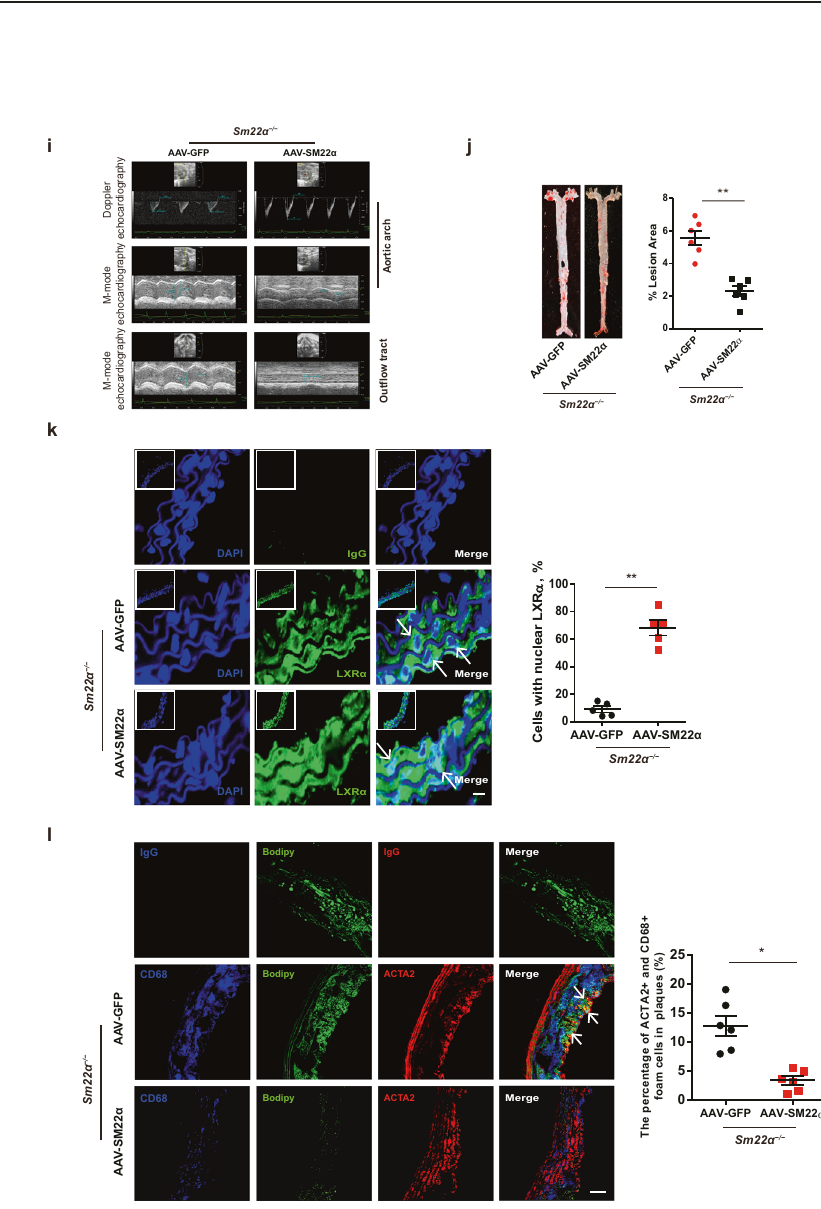
Fig. 5 G-actin interacts with and retains LXR α in the cytoplasm, blocking LXR α binding to Importin α . a Double immuno fl uorescence staining for G-actin (DnaseI, red) and LXR α (green) in WT VSMCs accompanied with the treatment of JPK or CytoB and also in Sm22 α − / − VSMCs. Scale bar, 10 μ m. b , c Co-immunoprecipitation of ACTA2 and LXR α ( b ) and LXR β ( c ) respectively in F- and G-actin fractions of WT and Sm22 α − / − VSMCs ( n = 3). d Double immuno fl uorescence staining of G-actin (Dnase1, red) and LXR α (green) or IgG in the atherosclerotic lesion in the aortic wall of Sm22 α − / − mice. Scale bar, 20 μ m. e Representative immuno fl uorescence staining for endogenous LXR α (green) and LXR α - GFP (green) in WT VSMCs transfected with HA-ACTA2 (red, stained by anti-HA antibody) or not. Scale bar, 15 μ m. f Representative immuno fl uorescence staining for LXR α -GFP (green) and HA-ACTA2 (red, stained by anti-HA antibody) in HEK-293A cells. Scale bar, 10 μ m. g − j Two-color STORM images and quanti fi cation of the colocalization degree between LXR α and G-actin as well as Importin α in WT VSMCs with ( h ) or without ( g ) CytoB treatment and Sm22 α − / − VSMCs with ( j ) or without ( i ) Ad-GFP-SM22 α infection ( n > 10). k Co- immunoprecipitation of LXR α and Improtin α , Improtin β or ACTA2 in WT and Sm22 α − / − V S MCs with or without JPK, CytoB, PDGF-BB and Ad-GFP-SM22 α treatment ( n = 3). l Double immuno fl uorescence staining for Importin α (red) and LXR α (green) in WT and Sm22 α − / − V S MCs as well as CytoB-treated WT VSMCs. Scale bar, 15 μ m. m Co-immunoprecipitation of LXR α and Importin α , Improtin β or ACTA2 in WT VSMCs transfected with HA-ACTA2 of different concentrations ( n = 3). Data and images represent at least three independent experiments. Cell Death and Disease (2021)